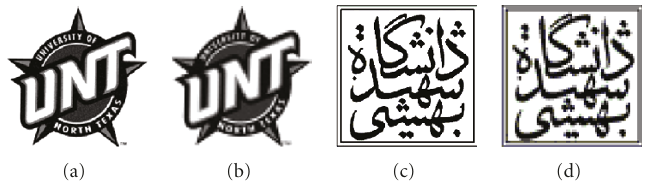
Figure 11: (a) and (c) Original watemarks, (b) and (d) Used watermarks.